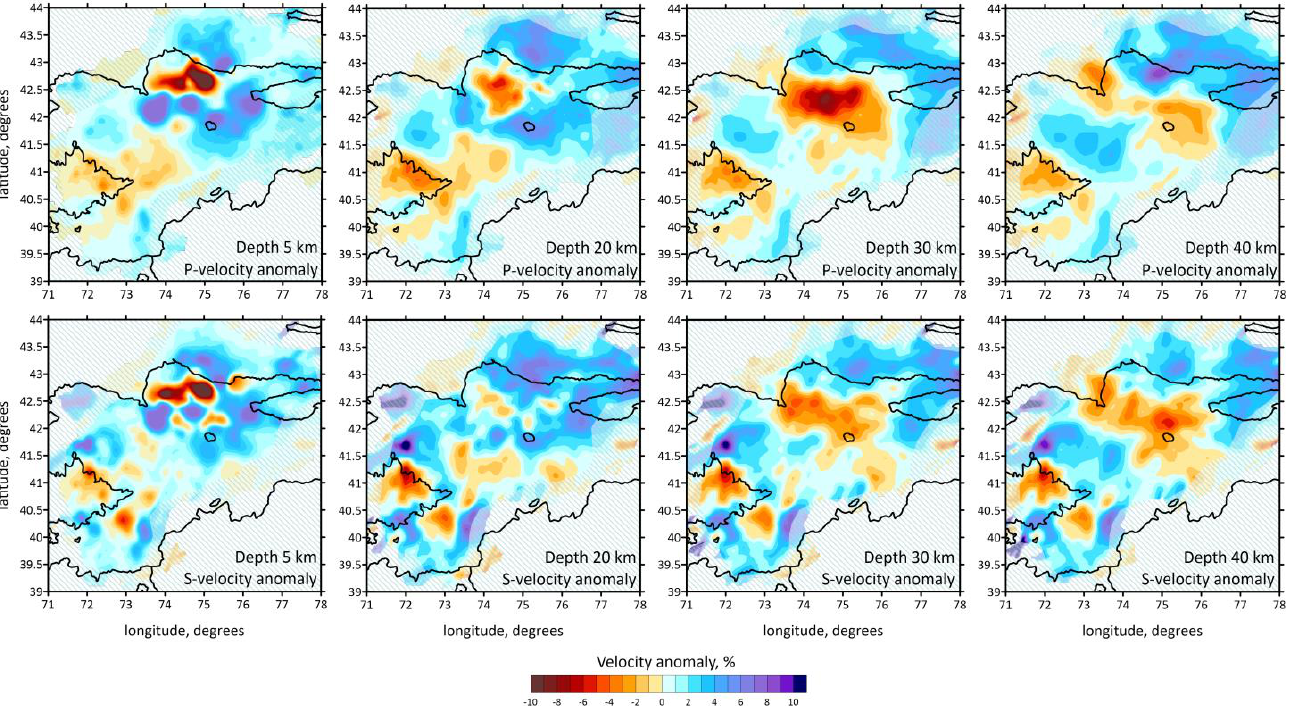
Figure 4. P- and S-velocity anomalies in the horizontal sections.